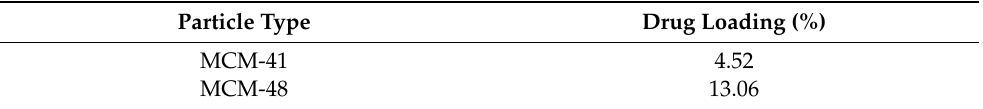
Figure 4. Thermogravimetric Analysis (TGA) of the pristine and drug-loaded Mesoporous Silica Nanoparticles (MSN). Table 2. Drug loading values determined by TGA analysis.